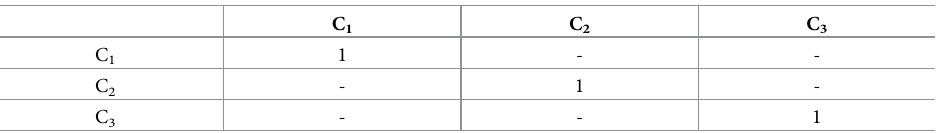
Table 4. The pair-wise comparisons of the first level